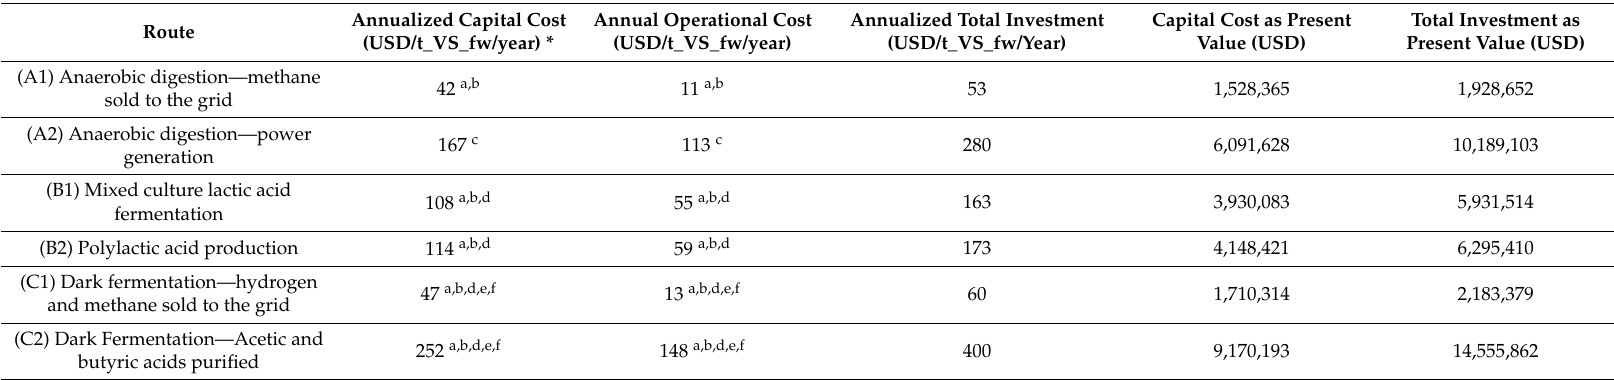
Table 1. Capital and operational costs, obtained from literature, for the different assessed scenarios. All scenarios considered a project time of 20 years, with an annual interest of 5%, and a designed capacity of 50 t/day of food waste, with 16% volatile solids